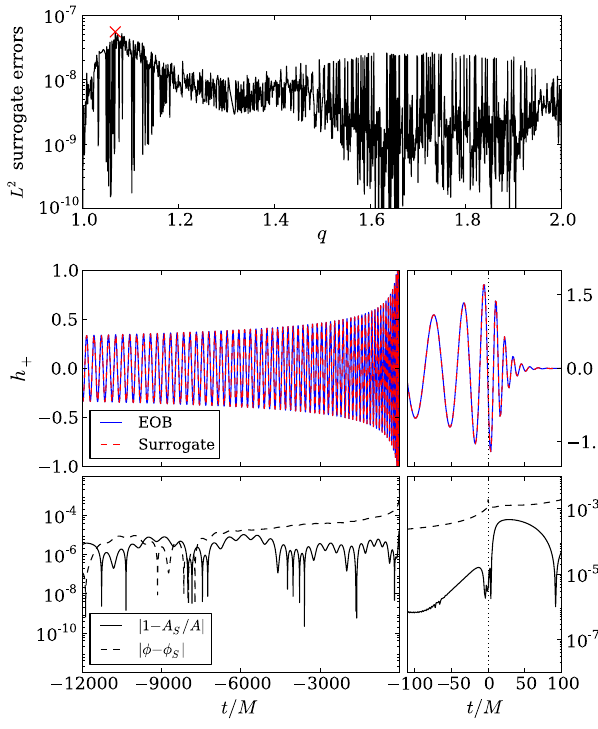
FIG. 9. Top panel: Surrogate model error defined by Eq. (31), which is related to the overlap error through Eq. (3), for 1,000 randomly selected mass ratios. The mass ratio yielding the largest surrogate model error is q ¼ 1 . 068 . Middle panel: The fiducial EOB waveform and its surrogate prediction for q ¼ 1 . 068 . There is visual agreement throughout the entire duration of ≈ 12 ; 000 M . Bottom panel: The fractional errors (32) in the amplitude and the phase difference between the fiducial EOB waveform and its surrogate model prediction for q ¼ 1 . 068 . The differences are smaller than the errors intrinsic to the EOB model itself, as well as those of state-of-the-art numerical relativity